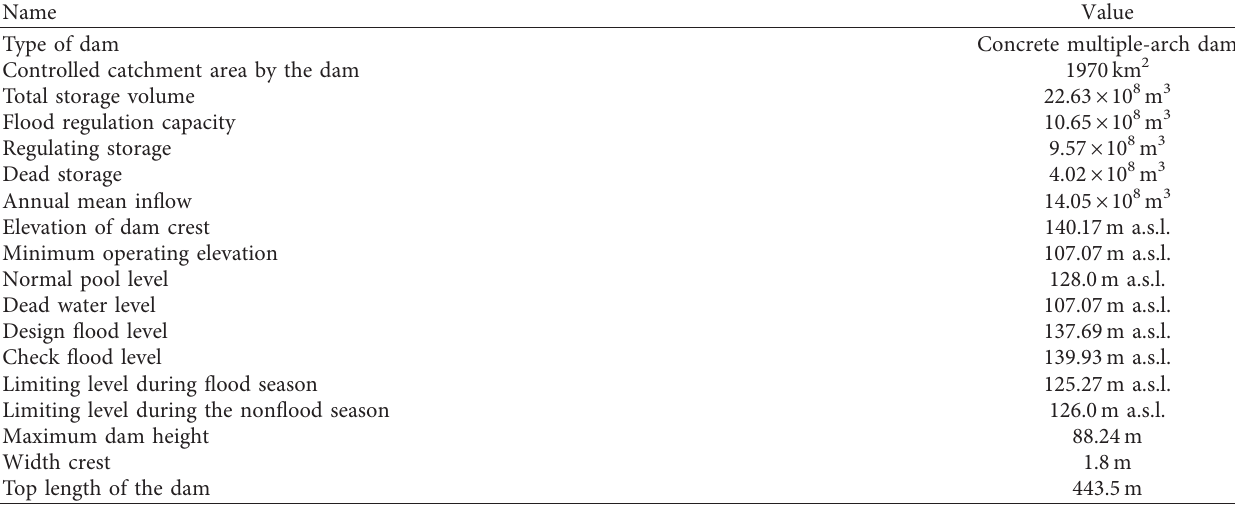
Figure 1: Basic geographic information of Meishan reservoir. (a) The location of Anhui Province (bold black line) in East Asia and the topography. (b) The location of the dam in Shi River and five counties (red dash line) irrigated by the reservoir. (c) The upstream catchment area of the dam and the land cover types in it. The red triangle indicates the dam position. Table 1: Characteristics of the Meishan reservoir project